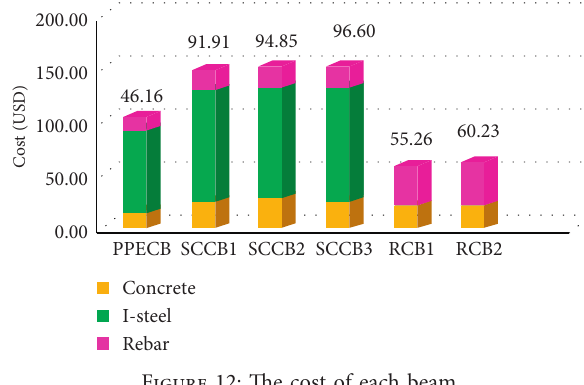
Figure 14: CO 2 emission from different beams.